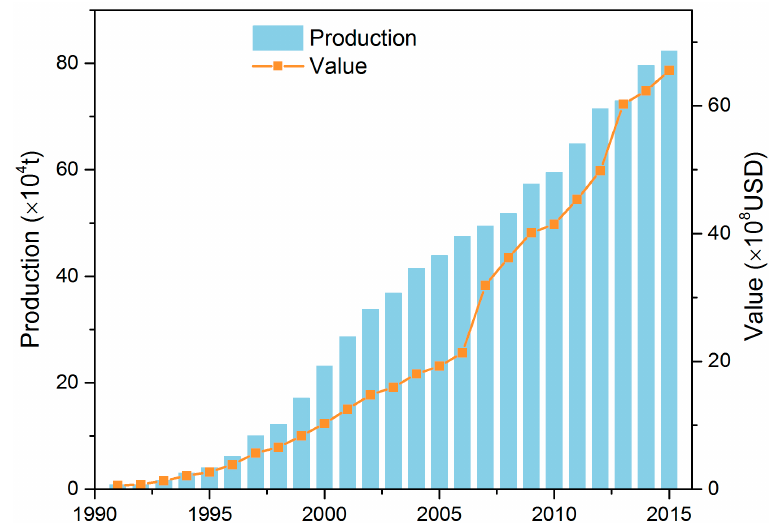
Figure 1. Trends in the production ( × 10 4 t) and value ( × 10 8 United States Dollars (USD)) of Chinese mitten crab cultures from 1991 to 2015 in China (based on data from FAO (Food and Agriculture Organization of the United Nations) 2016 and China fishery statistics yearbooks from 2012 to 2016).